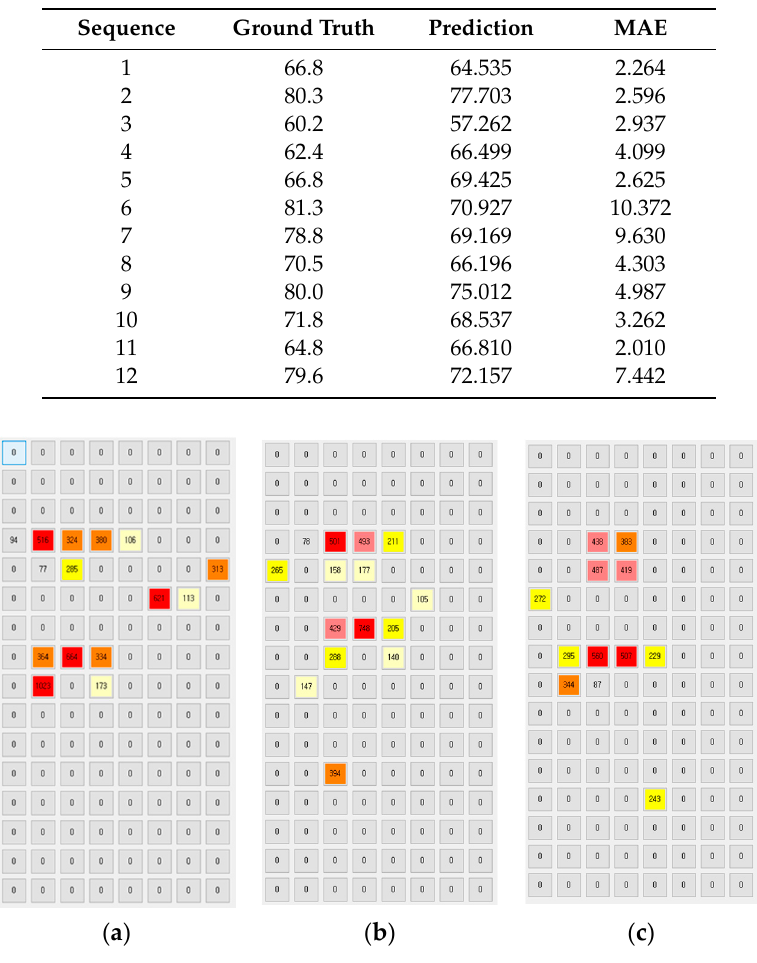
Figure 13. ( a ) The pressure distribution of sample 6 and ( b , c ) the pressure distributions of the two samples with the different body weights.